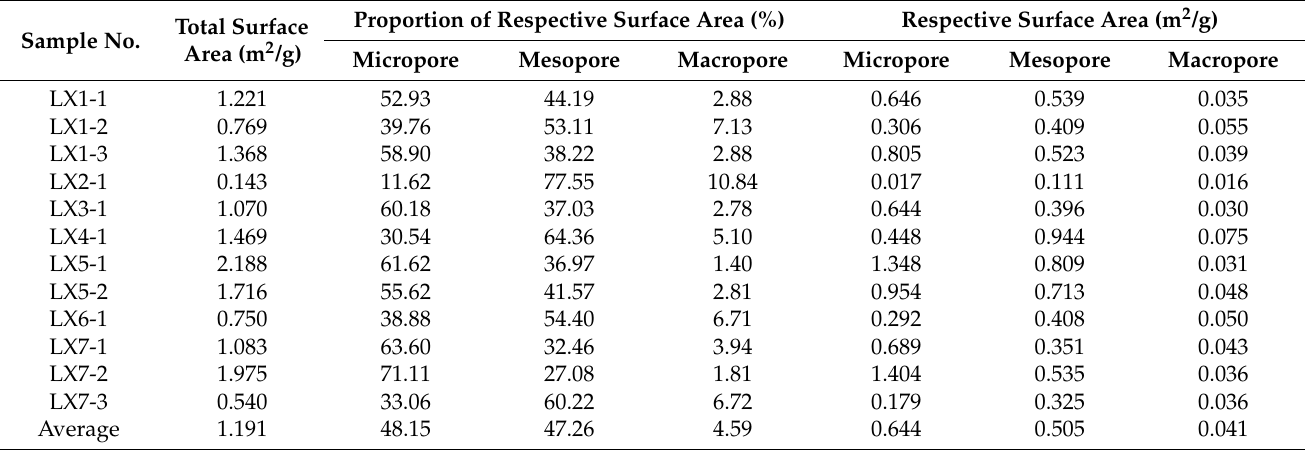
Table 5. Pore structure parameters of the shale in the study area (pore volume). Sample